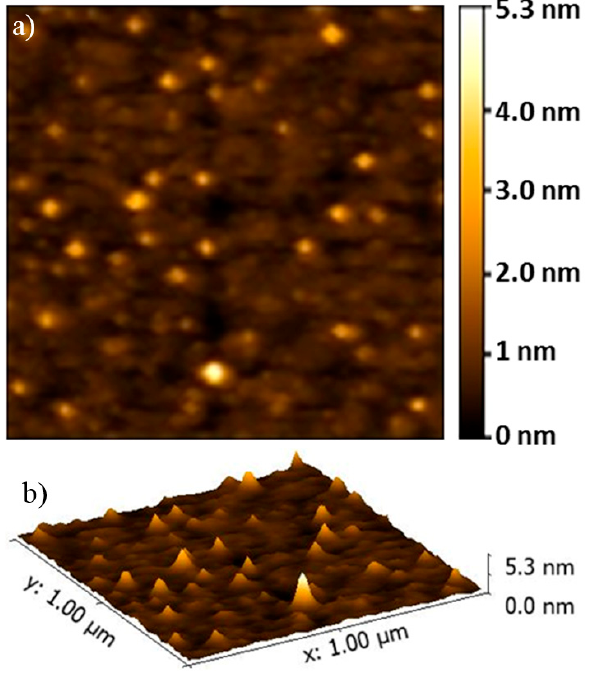
Figure 5. AFM images of Au-3MPS deposited on Si/SiO 2 : 1 μ m × 1 μ m 2D ( a ) and 3D ( b ) topography. The Au-3MPS NPs show a regular round shape, with a maximum z-dimension (height) of about 5 nm. Considering the curvature radius of the tip used here (about 8 nm), only the z-dimension of the observed NPs is representative of their real dimensions. Their lateral dimensions are enlarged by the tip dimensions (always the smaller object taking an image of the larger one), by 5 nm for the NPs height, and therefore, the real diameter is smaller than that found by DLS measurements, because in the latter case, the solvent plays a role in the swelling of nanoparticles. In order to obtain a complete morphological characterization, the pristine dried sPEEK membrane has been compared with the sPEEK membrane after hydrothermal treatment and the AuNP’s embedded membrane. Figure 6a shows the 2D and 3D topography AFM images of the pristine sPEEK